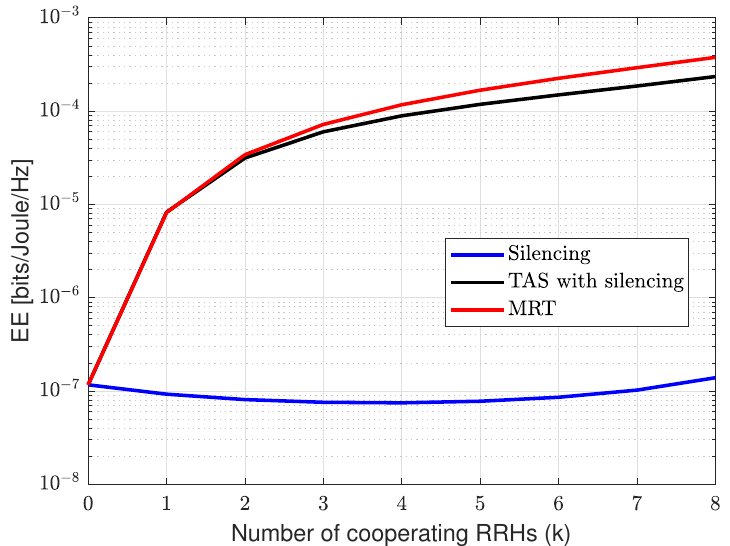
Figure 8. Illustration of EE for silencing, TAS with silencing and MRT with the N = 10 and (cid:101) th = 10 − 5 as function of k